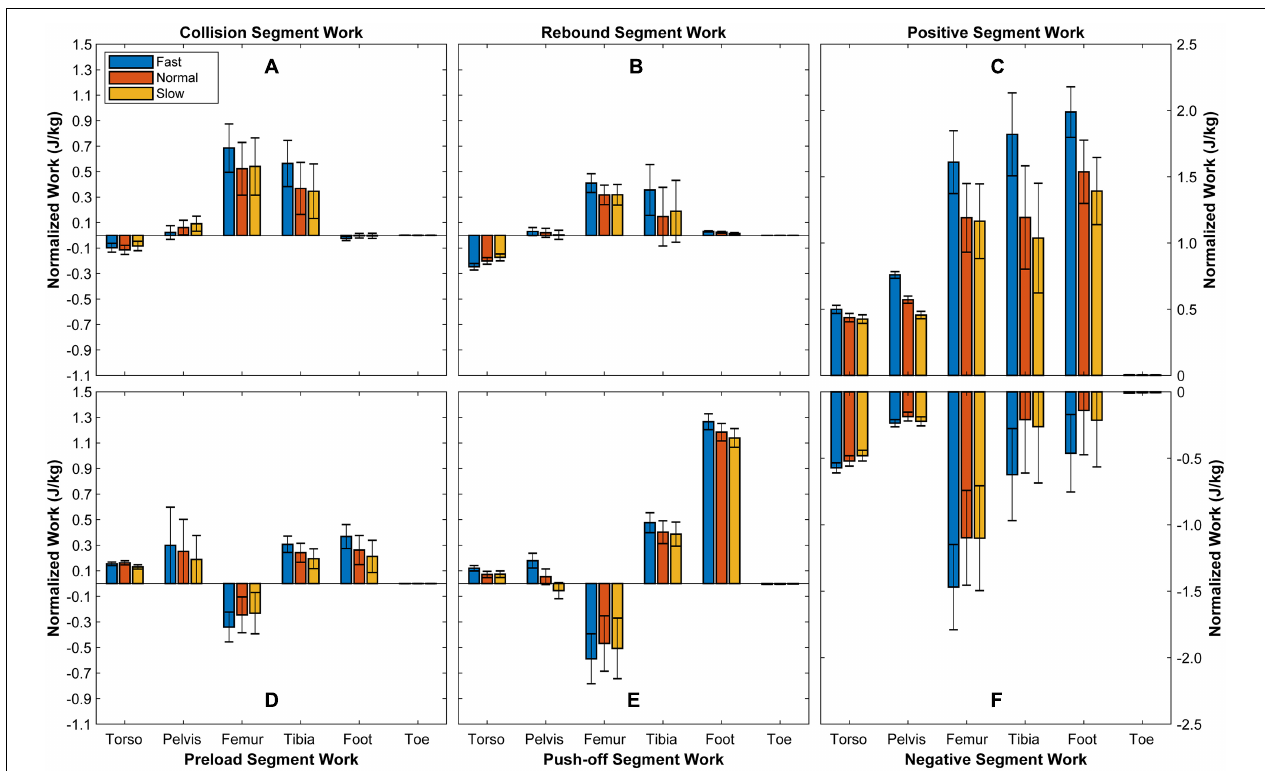
FIGURE 2 | Mechanical energy change of segments during stance phase. It demonstrates the mechanical energy change in each segment during collision (A) , rebound (B) , preload (D) , and push-off (E) , as well as the positive (C) and negative (F) mechanical work applied to each segment during the whole stance phase. Bars depict mean; N = 6; error bars,